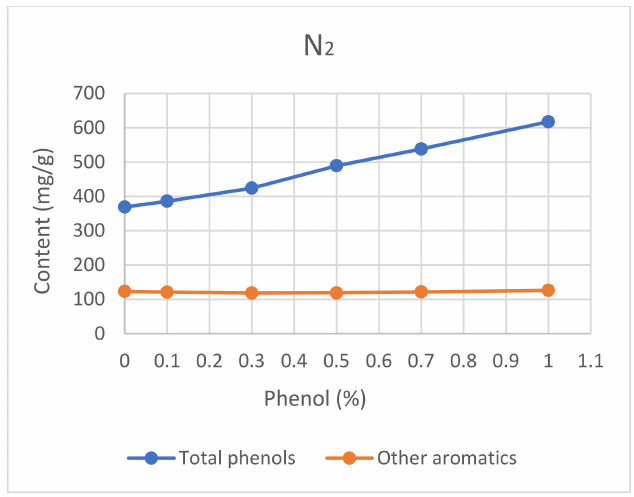
Figure 5. The influence of the phenol concentration on the formation of monomeric depolymerization products of lignin in a nitrogen atmosphere.